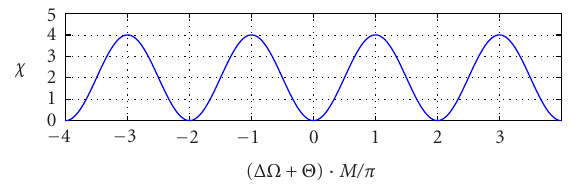
Figure 2: Cost function for carrier frequency o ff set correction.